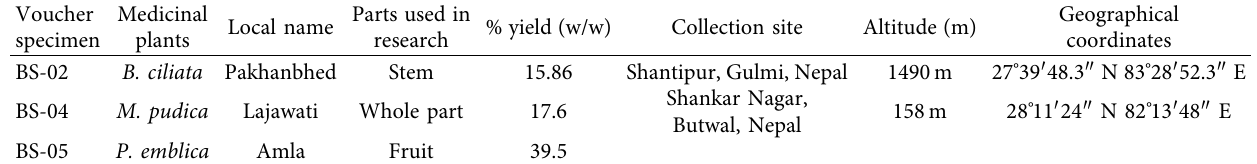
Table 1: Details of medicinal plants under study, their collection sites, parts used, and percentage